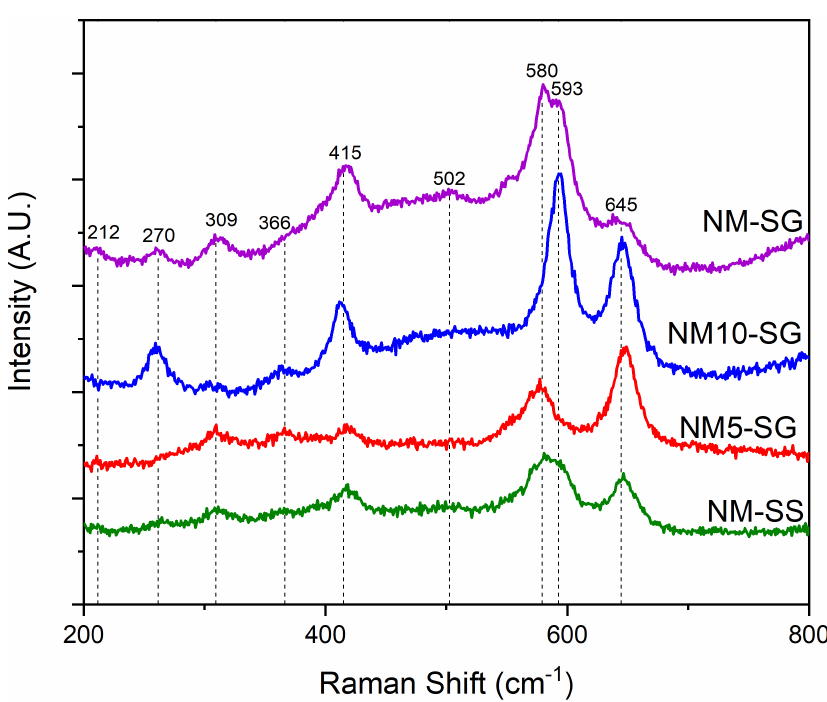
Figure 2. Comparison between the Raman spectra of the four